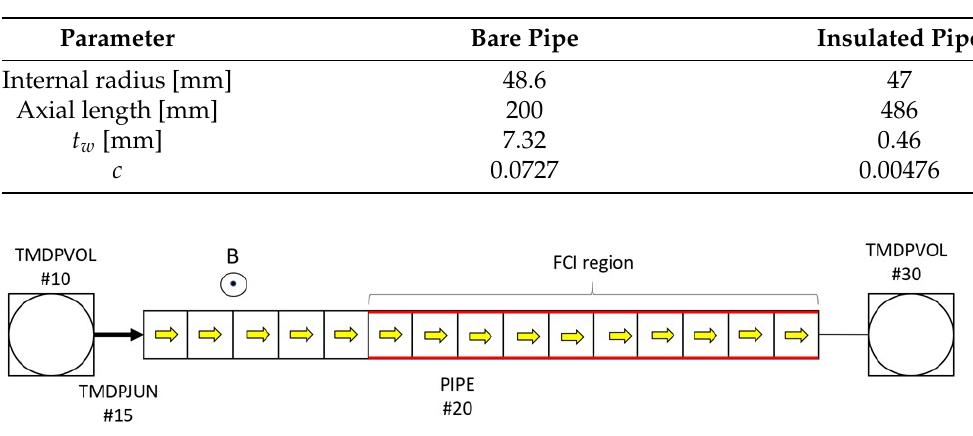
Table 4. Model geometry parameters.